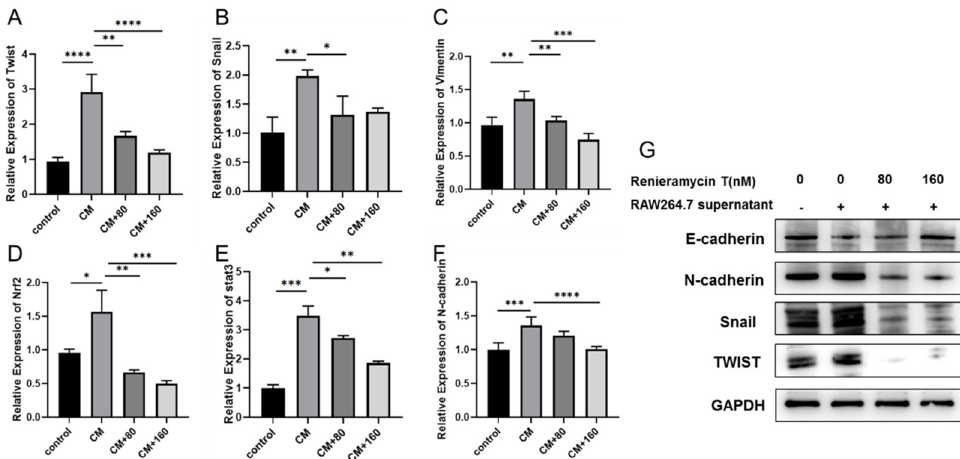
Figure 3. RT inhibits the expression of B16F10 tumor metastasis-related genes. ( A – F ) Quantitative analyses of twist, snail, vimentin, and N-cadherin mRNA in B16F10 treated with RT for 48 h at the control and conditioned cells. ( G ) Western blotting was performed to check the expression of twist, snail, vimentin, and N-cadherin in B16F10 treated with RT for 48 h at the control and conditioned cells. (n = 3, * p < 0.05, ** p < 0.01, *** p < 0.001, **** p < 0.0001).